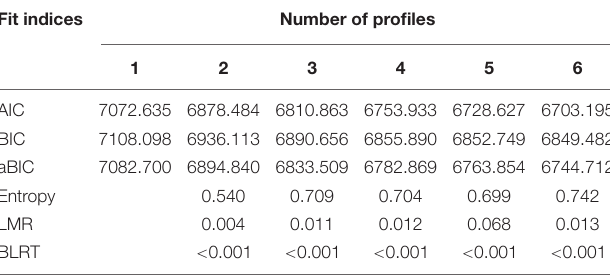
TABLE 2 | Fit indices for six different latent empathy profiles ( n = 622). Fit indices Number of profiles